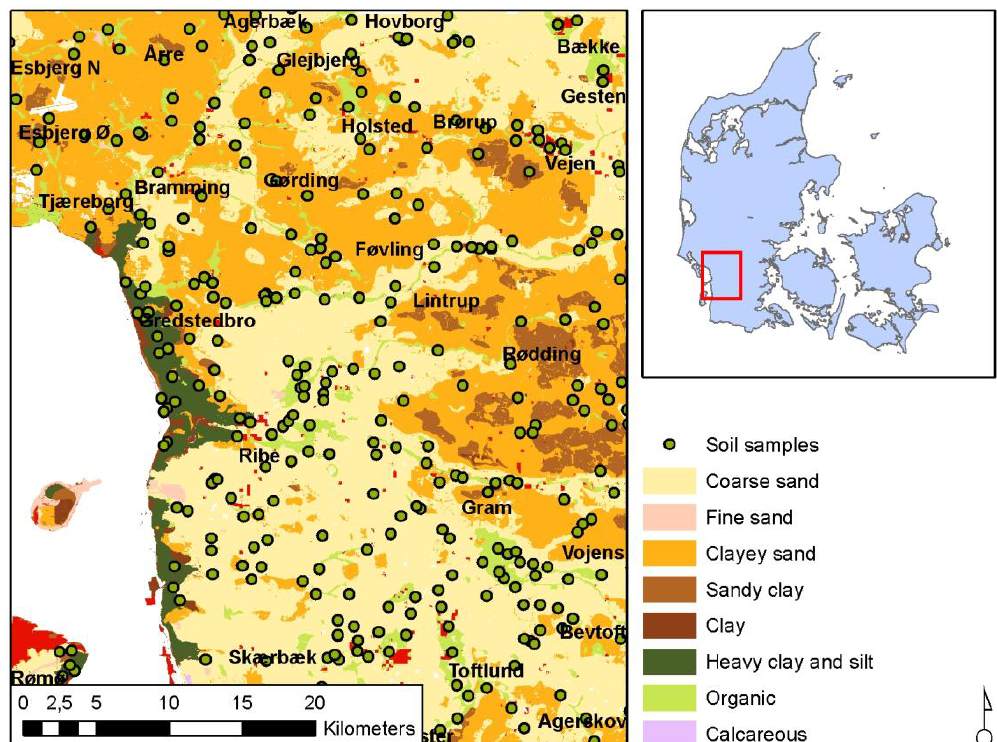
Fig. 1. Soil map of the study area within Denmark (Madsen et al.,